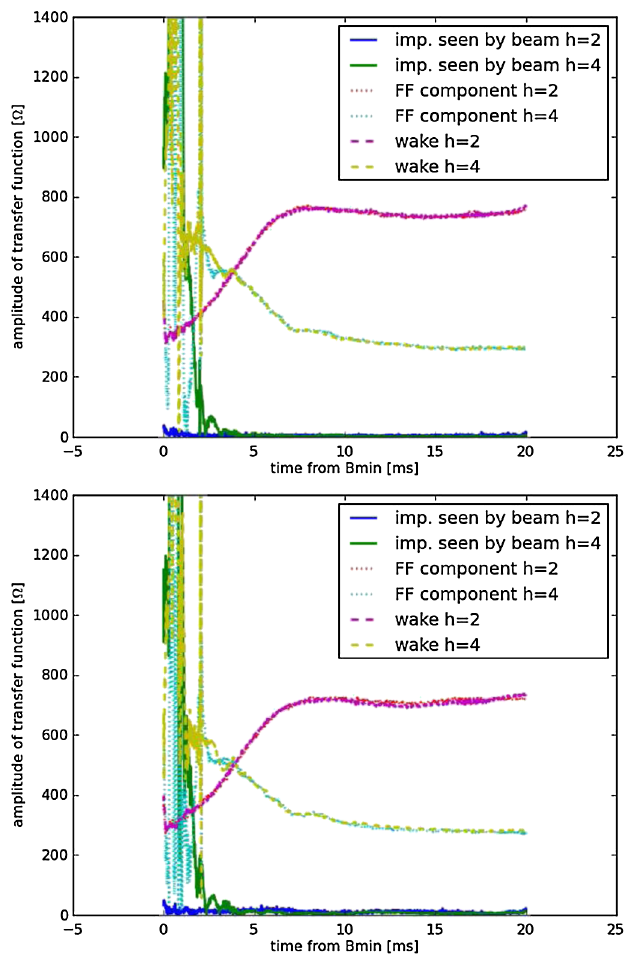
FIG. 24. Cavity #2 impedance seen by the beam as function of time—(top) just after the feedforward patterns are optimized in June 2010 and (bottom) as of March 2011. The impedance seen by the beam is still low. It was not necessary to optimize the patterns